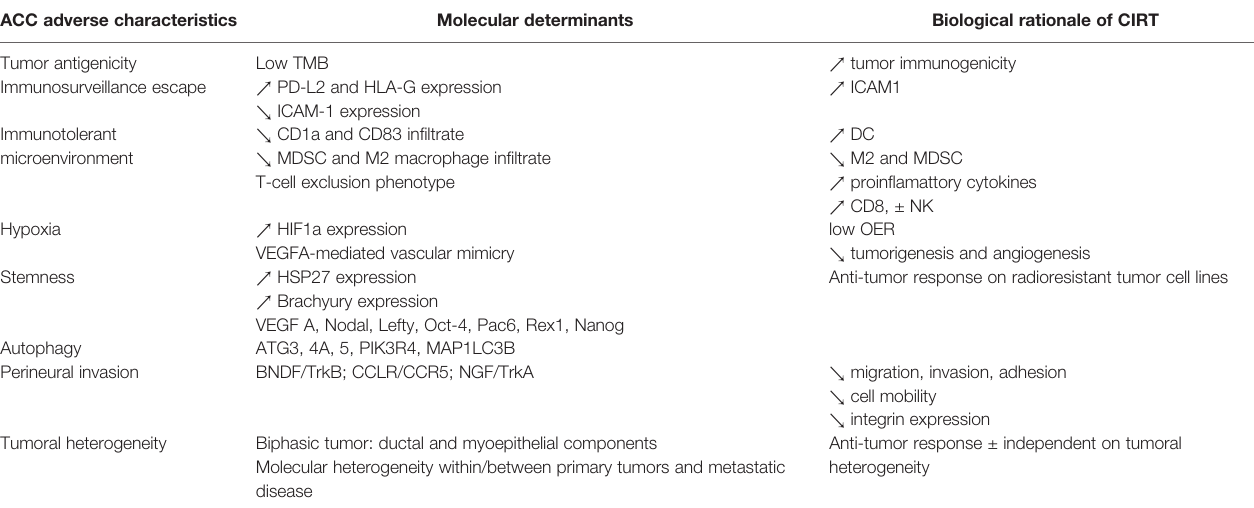
TABLE 1 | Biological rationale for adenoid cystic carcinoma (ACC) with carbon ion radiation therapy